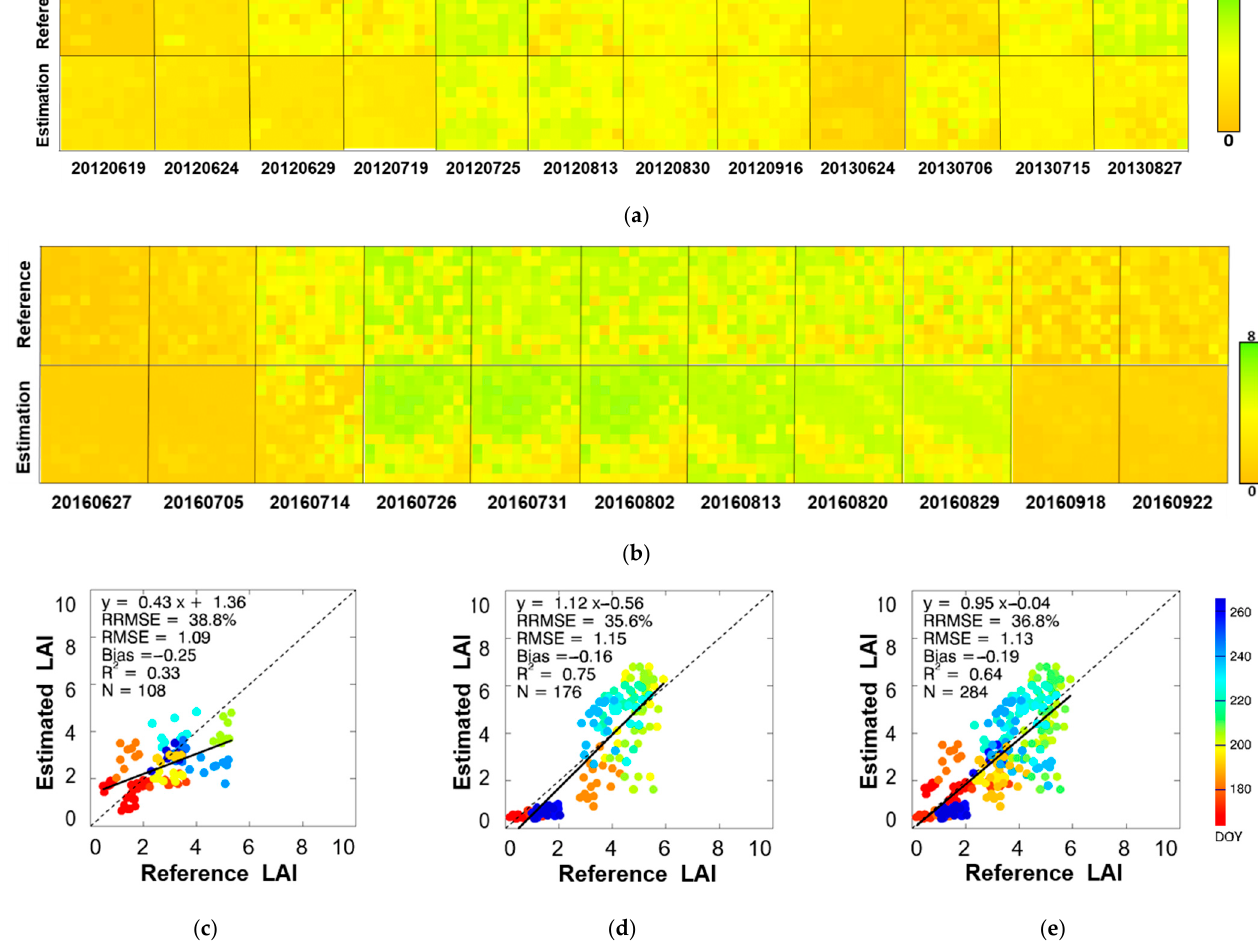
Figure 9. Comparison of the estimated LAIs to the upscaled reference LAI maps: ( a , b ) show the results at 500 m in Honghe ( a ) and Hailun ( b ); ( c – e ) show the results for 3 × 3 MODIS pixels at 1.5 km in Honghe ( c ), Hailun ( d ), and both sites ( e ). The colours indicate the different observation dates.